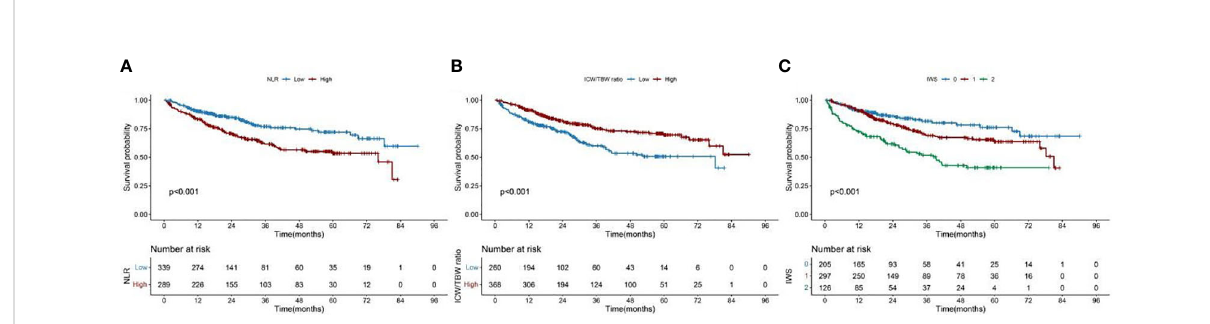
FIGURE 2 Kaplan – Meier curve of the NLR and ICW/TBW ratio, and in fl ammation-water score in patients with colorectal cancer. (A) - NLR, neutrophil- lymphocyte ratio; (B) - ICW/TBW ratio, intracellular water/total body water ratio; (C) - IWS, in fl ammation-water ratio.